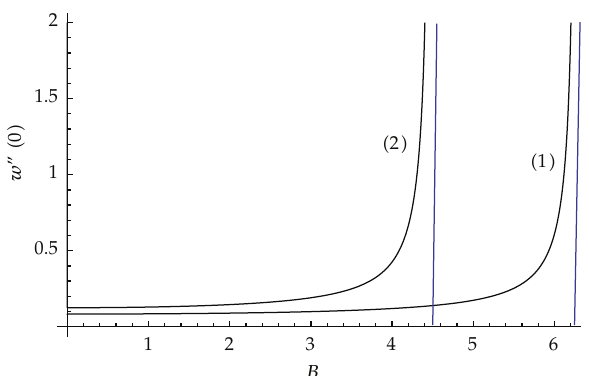
Figure 12: Graphs of the curvature w (cid:2)(cid:2) (cid:3) 0 (cid:4) at x (cid:5) 0 plotted against B for a beam with: (cid:3) 1 (cid:4) x (cid:5) 0 clamped and x (cid:5) 1 clamped, (cid:3) 2 (cid:4) x (cid:5) 0 clamped and x (cid:5) 1 simply